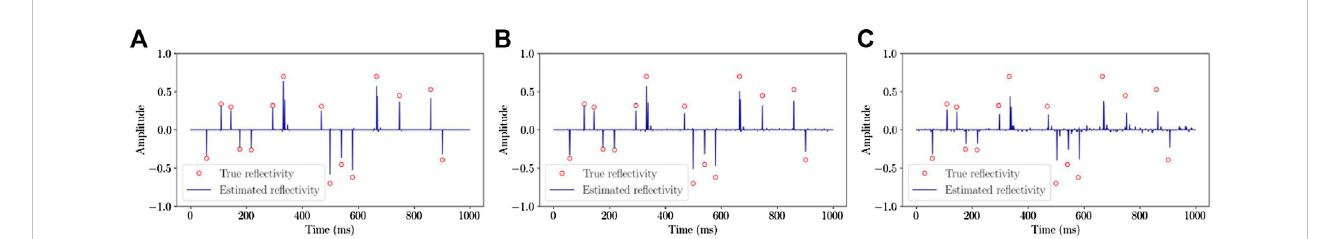
FIGURE 7 The estimated re fl ectivity series by the Gabor deconvolution. (A) The estimated re fl ectivity series corresponding to the synthetic traces shown in Figure 6A. (B) Theestimated re fl ectivityseries correspondingto thesynthetictracesshown inFigure 6B. (C) The estimatedre fl ectivityseries correspondingto the synthetic traces shown in Figure 6C. The true non-zero re fl ectivity coef fi cients are shown by the red points.